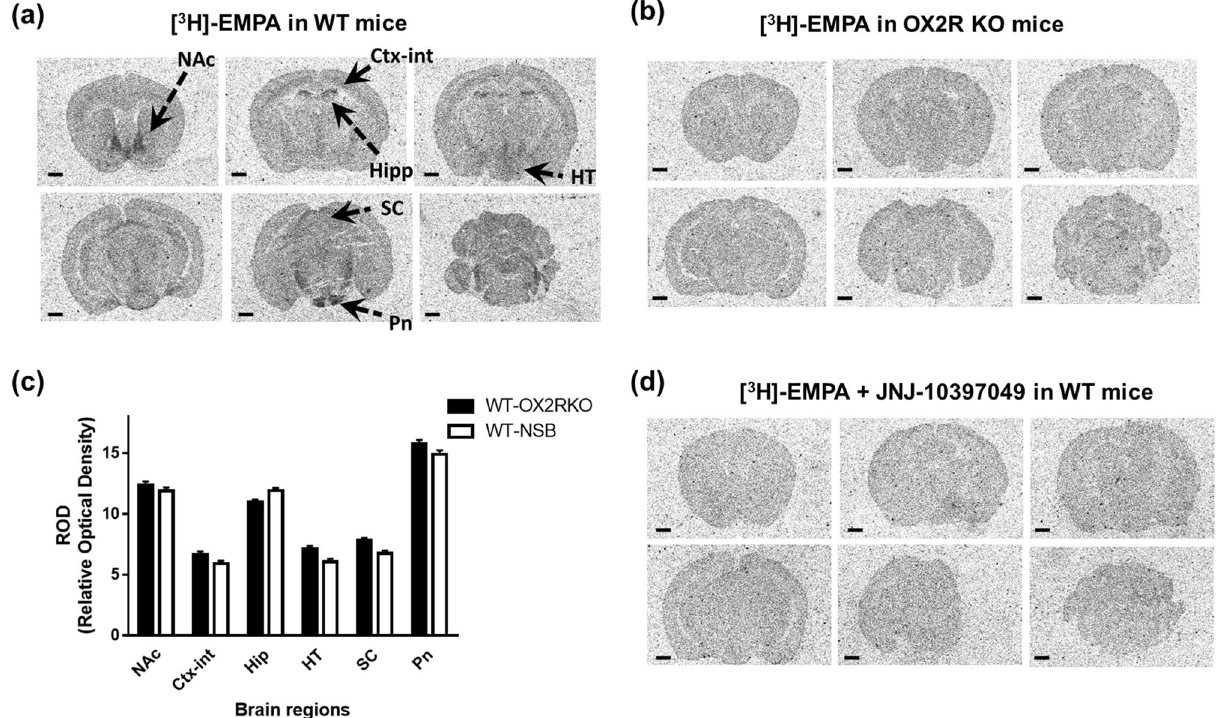
Figure 1. Selective binding of [ 3 H]-EMPA to OX2R assessed using brain sections isolated from wild-type (WT) and OX2R knockout (KO) mice. ( a ) Representative autoradiograms evaluating [ 3 H]-EMPA binding in six coronal brain sections isolated from WT mice are depicted. All the brain samples were collected at approximately the same time (zeitgeber time (ZT) 6 ‒ 8). Scale bar represents 1 mm. ( b ) Representative autoradiograms evaluating [ 3 H]-EMPA binding in six coronal brain sections obtained from OX2R KO mice are depicted. All the brain samples were collected at approximately the same time (ZT6 ‒ 8). Scale bar represents 1 mm. ( c ) [ 3 H]-EMPA binding was quantified (n = 4) in terms of the relative optical density (ROD) in six regions indicated in ( a ) ( NAc nucleus accumbens, Ctx-int internal layer of cortex, Hip hippocampus, HT hypothalamus, SC superior colliculus, and Pn pontine nuclei) using coronal brain sections obtained from OX2R KO mice and their WT littermates. The density of specific binding of [ 3 H]-EMPA in WT mice was obtained by calculating the difference between the binding observed in WT mice and OX2R KO mice or by calculating the difference between total binding and non-specific binding (NSB) assessed in the presence of 10 µM JNJ-10397049 in WT mice and is shown using filled-in columns (WT-OX2R KO) or blank columns (WT-NSB), respectively. Data are presented as mean ± standard error of the mean. ( d ) Representative autoradiograms evaluating [ 3 H]-EMPA binding in the presence of 10 µM JNJ-10397049 as NSB in six coronal brain sections obtained from WT mice are shown. All brain samples were collected at approximately the same time (ZT6 ‒ 8). Scale bar represents 1 area), mammillary nuclei of hypothalamus, thalamus (medial geniculate nucleus, ventromedial nucleus, and laterodorsal nucleus), periaqueductal gray, dorsal raphe nucleus, median raphe nucleus, locus coeruleus, pedun-